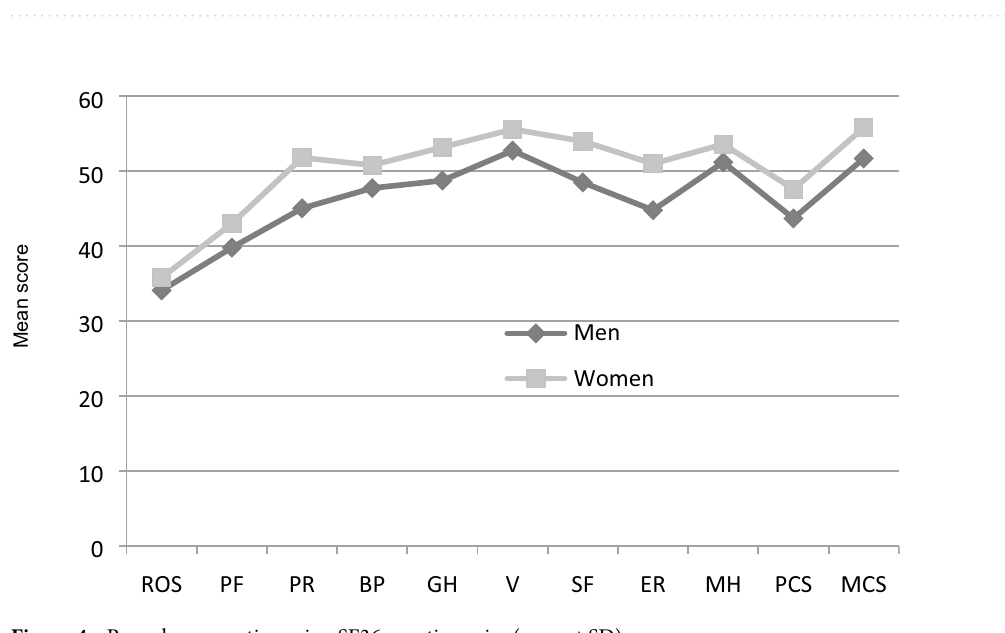
Table 3. Relationship between the three questionnaires. Spearman correlation coefficient data are provided ( p value).